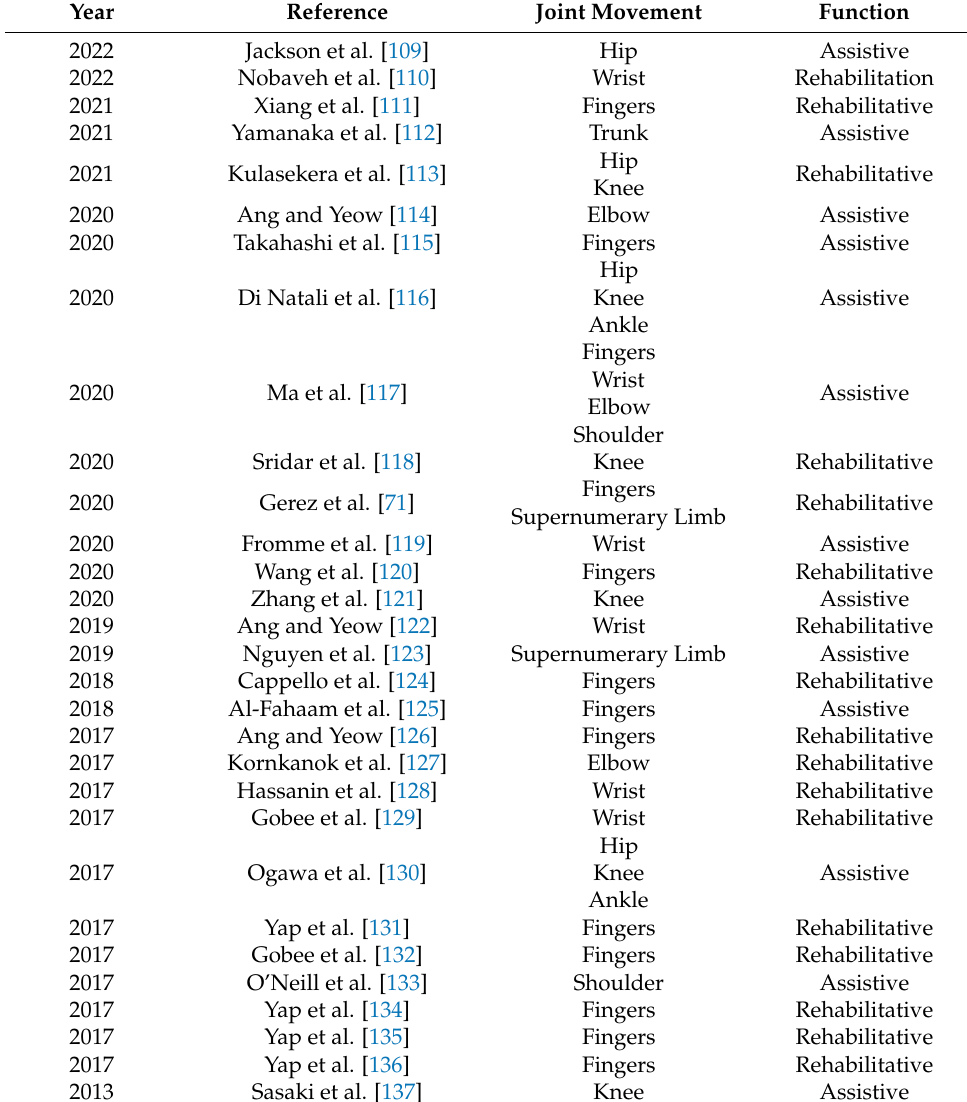
Table 2. List of publications that describe pneumatic soft